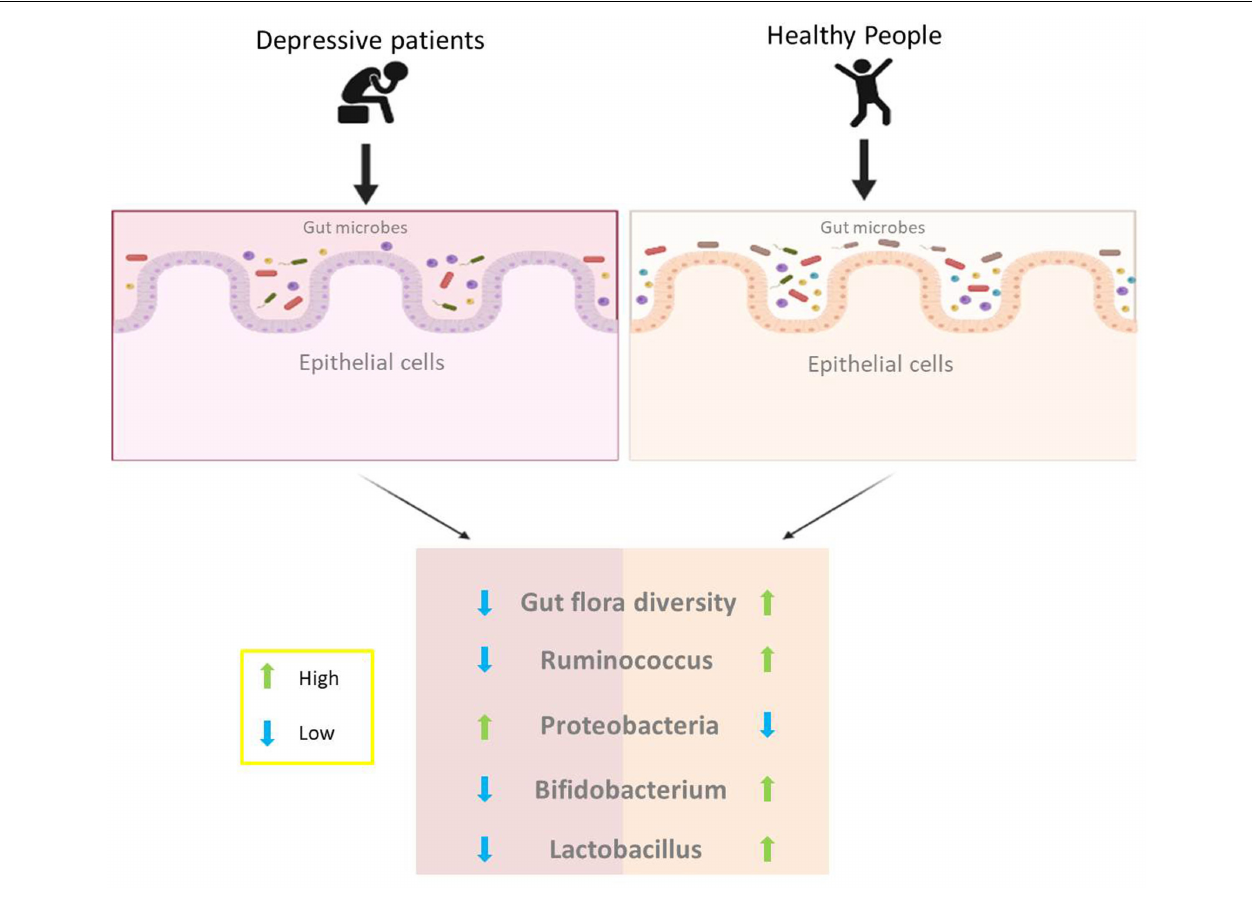
FIGURE 3 | Differences in intestinal flora between depressed and healthy